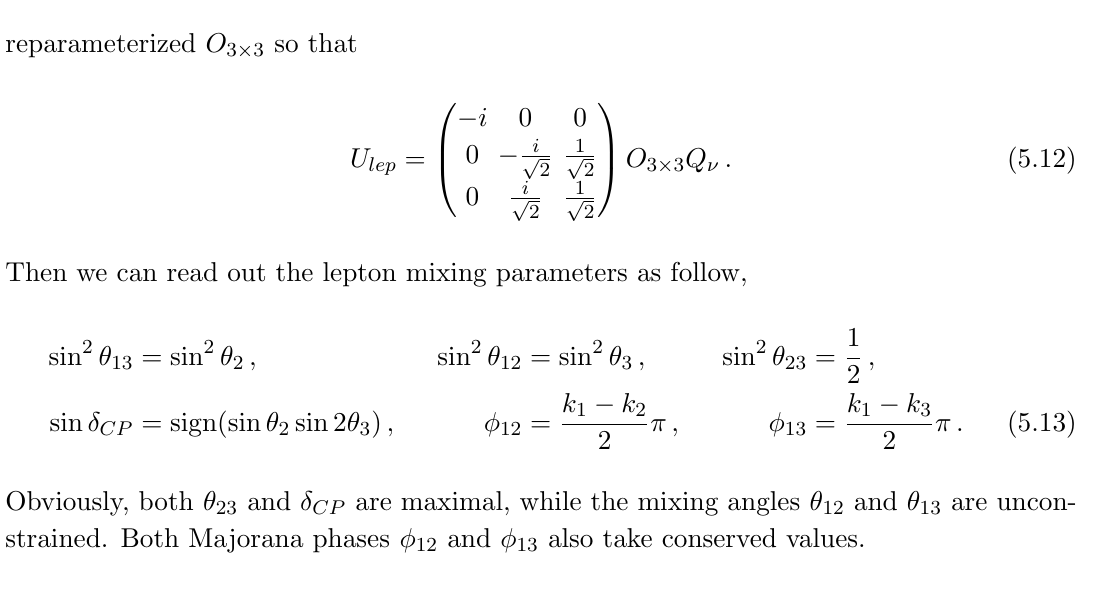
Figure 4 . Correlations between mixing angles and CP phases from eq. (5.10). These hold when X 2 is preserved by the neutrino sector. In all panels the green and magenta regions correspond to the Majorana phases (cid:30) 12 and (cid:30) 13 , respectively, while the blue regions in the upper panels correspond to the Dirac phase (cid:14) CP